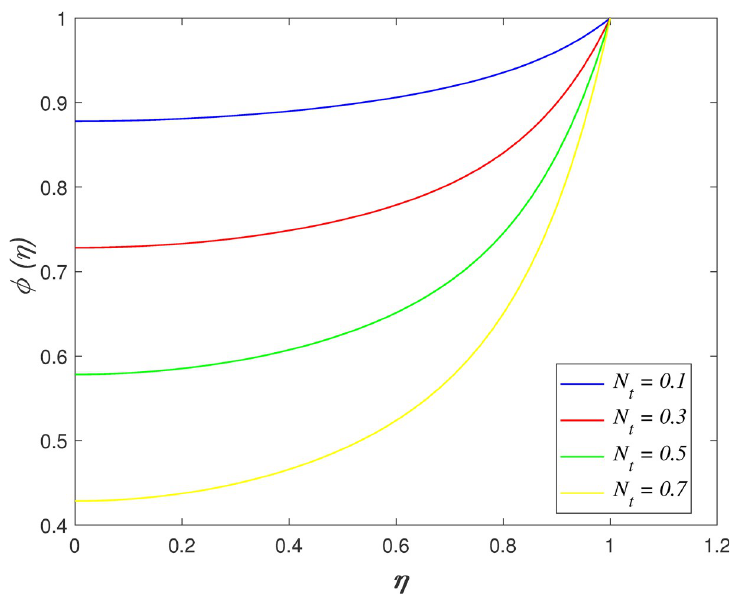
Fig 23. Impact of N